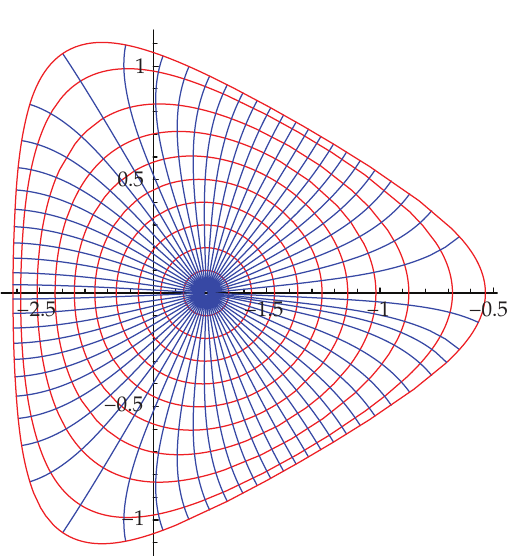
Figure 8: Interior of the Koch snowflake, Step